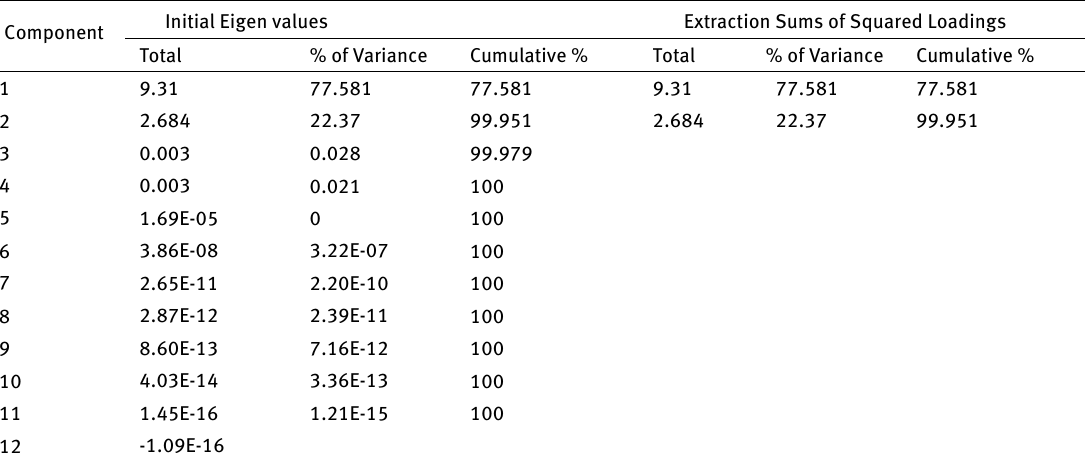
Table 2: Total Variance using the Extraction Method, Principal Component Analysis